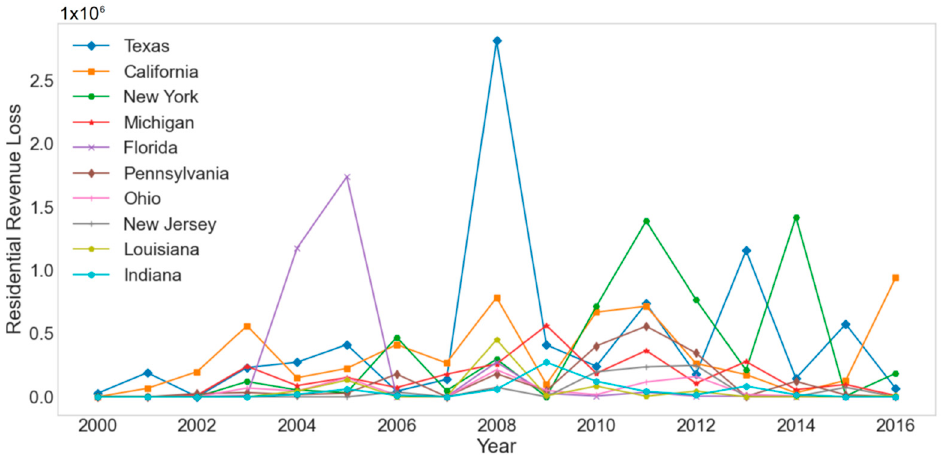
Figure 10. Revenue loss in residential sector for top ten individual states during 2000–2016 due to power outages.